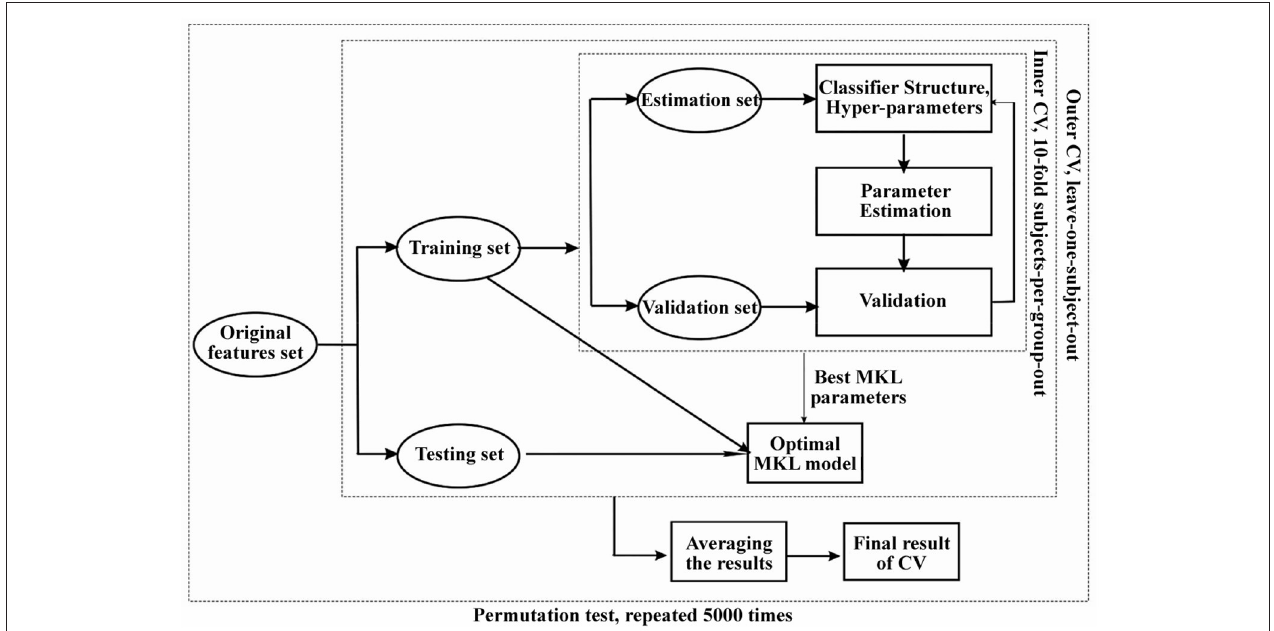
FIGURE 2 | The flow chart of machine learning based multivariate pattern analysis (MVPA) and nested cross-validation pipeline used in our study. Permutation test was used to evaluate the significance of the classification performance for 5,000 times